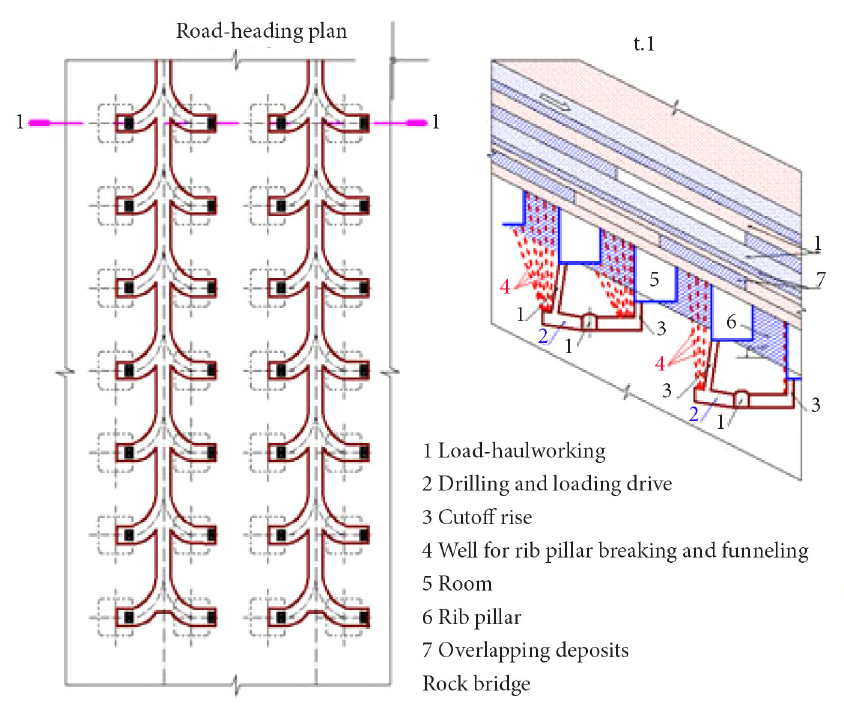
Figure 2. The proposed design of the drawing of caved ore from the rib pillar at the stope s ill in the rock mass of flat overlapping